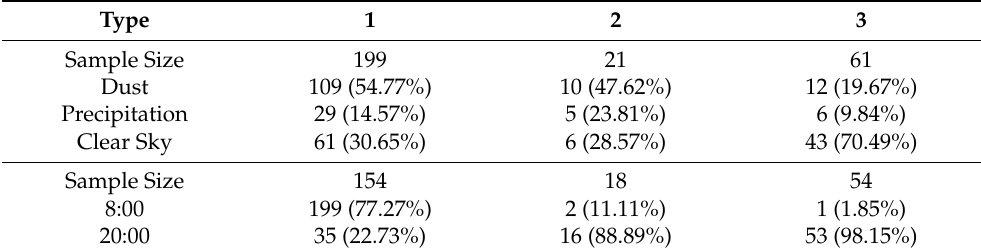
Table 2. Weather conditions and percentage of observed moments when PBLH inversion results of CDWL and GTS soundings were divided into three